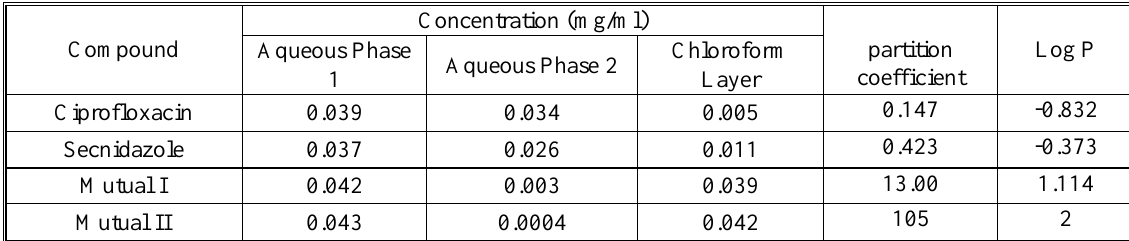
Table 4. The partition coefficient comparison